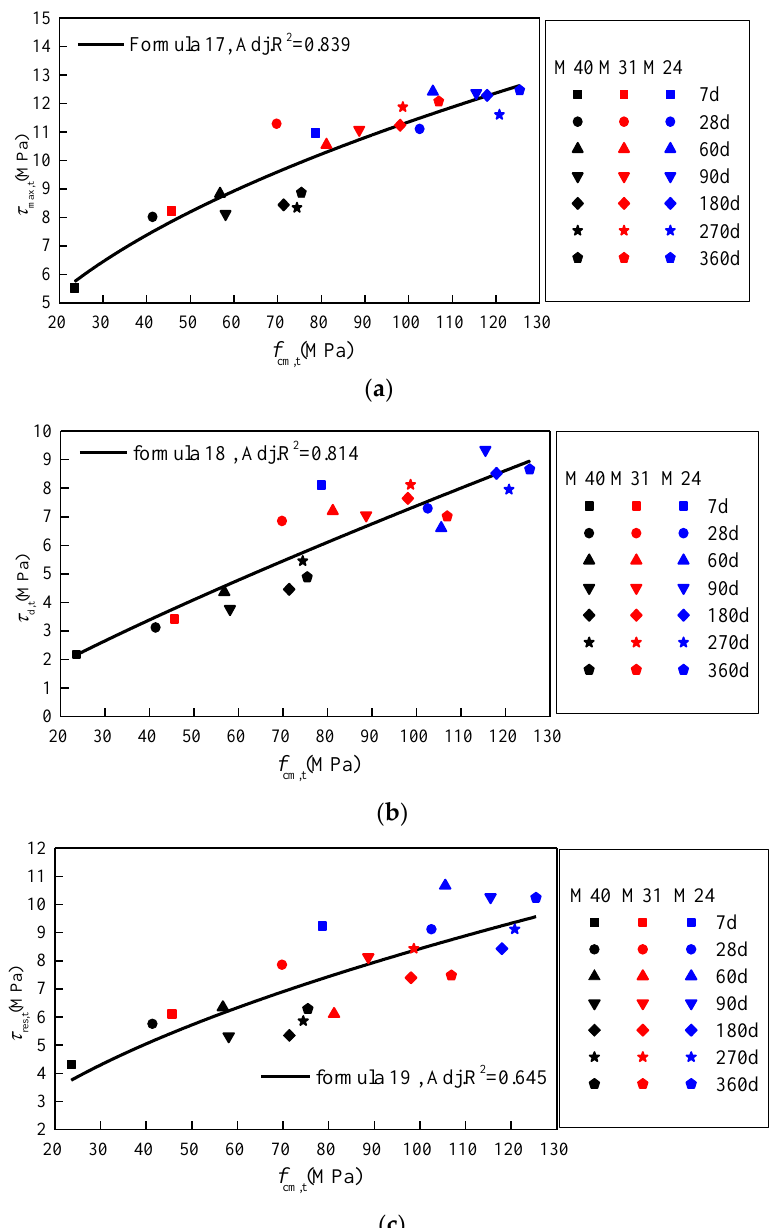
Figure 8. Relationship of bond strengths and compressive strength of mortar. ( a ) τ max,t ( b ) τ d,t ( c ) τ r es,t .